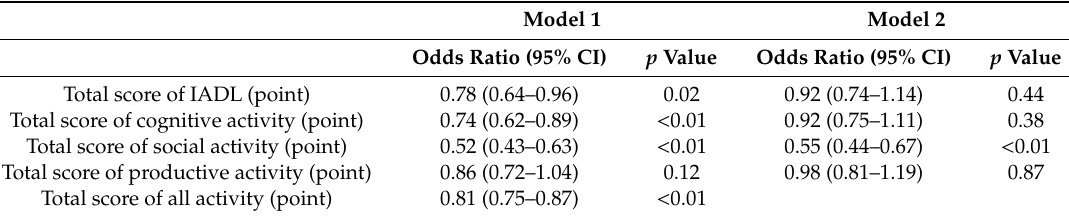
Table 4. Relationships between frailty status and lifestyle